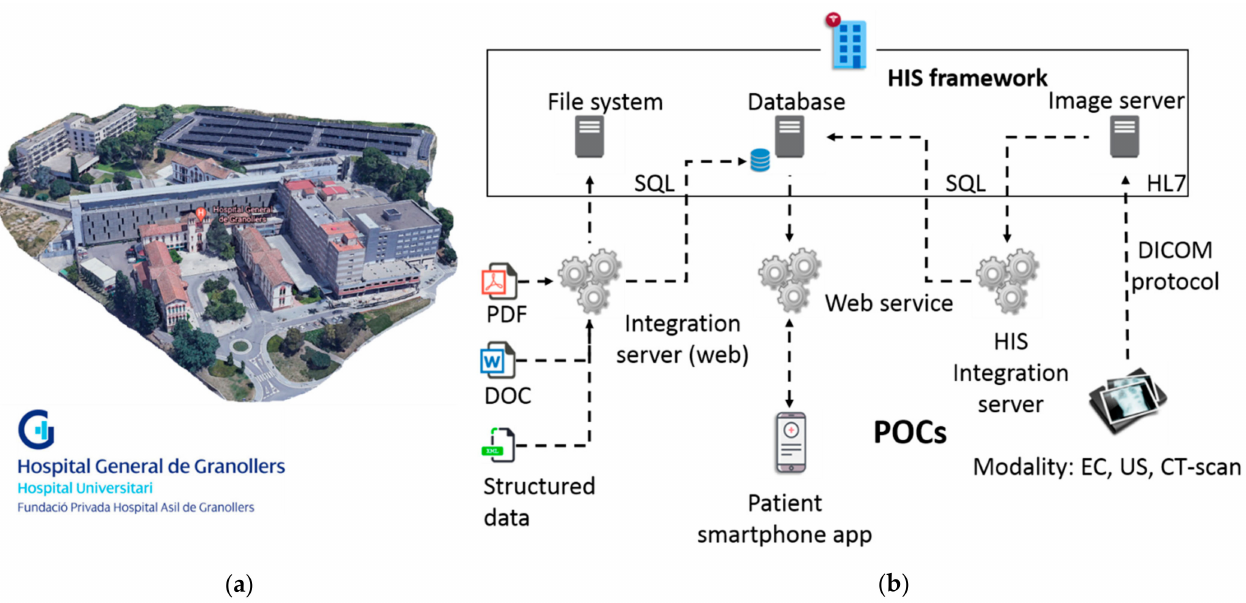
Figure 1. The experimental infrastructure has been designed and develop at FPHAG. ( a ) FPHAG facilities’ view including: Granollers General Hospital, Adolfo Montañ á Geriatric, the Knowledge Building and the surrounding facilities and services. ( b ) Topological representation of the IT infrastructure designed and develop to support the use case